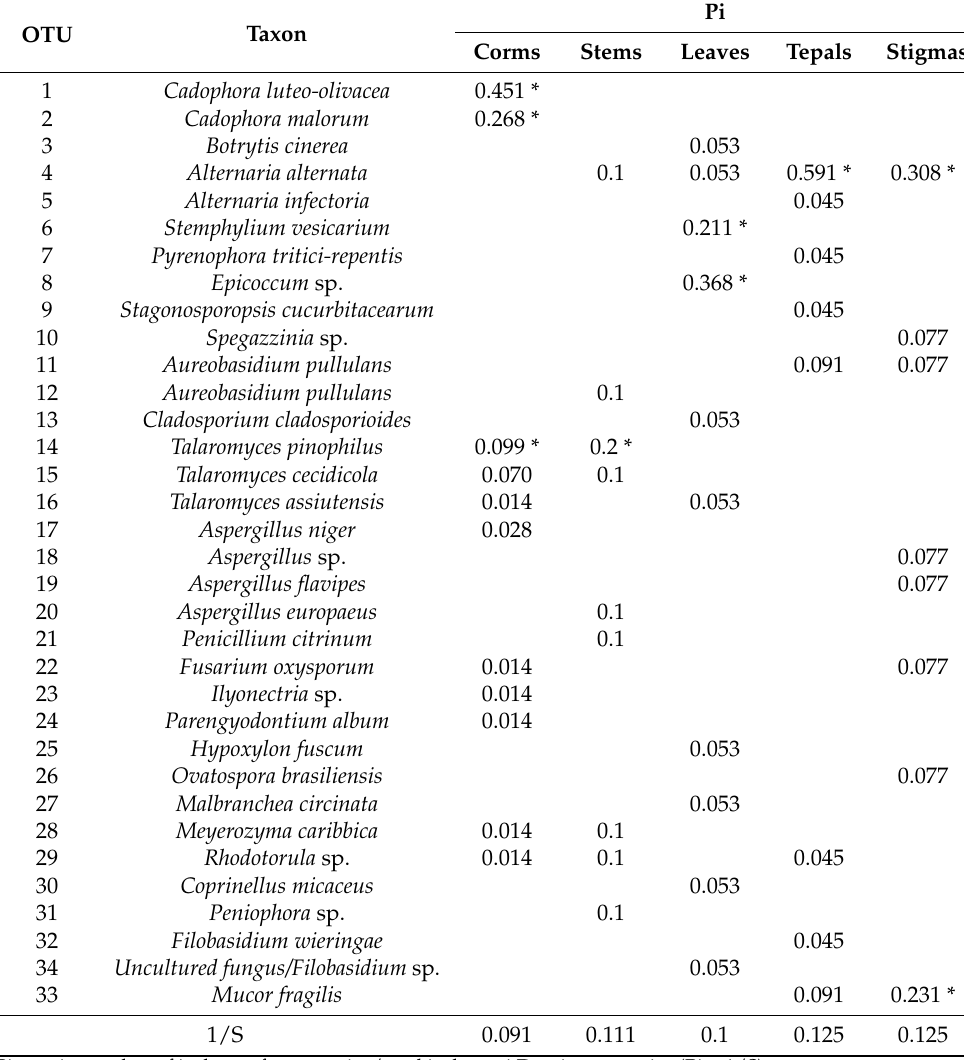
Table 3. Relative abundance of the OTUs and dominant fungal species in the different tissues of C. sativus healthy